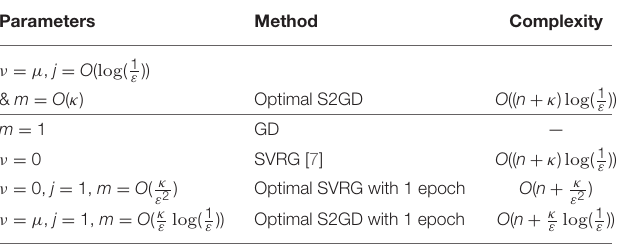
TABLE 2 | Summary of complexity results and special cases. Parameters Method